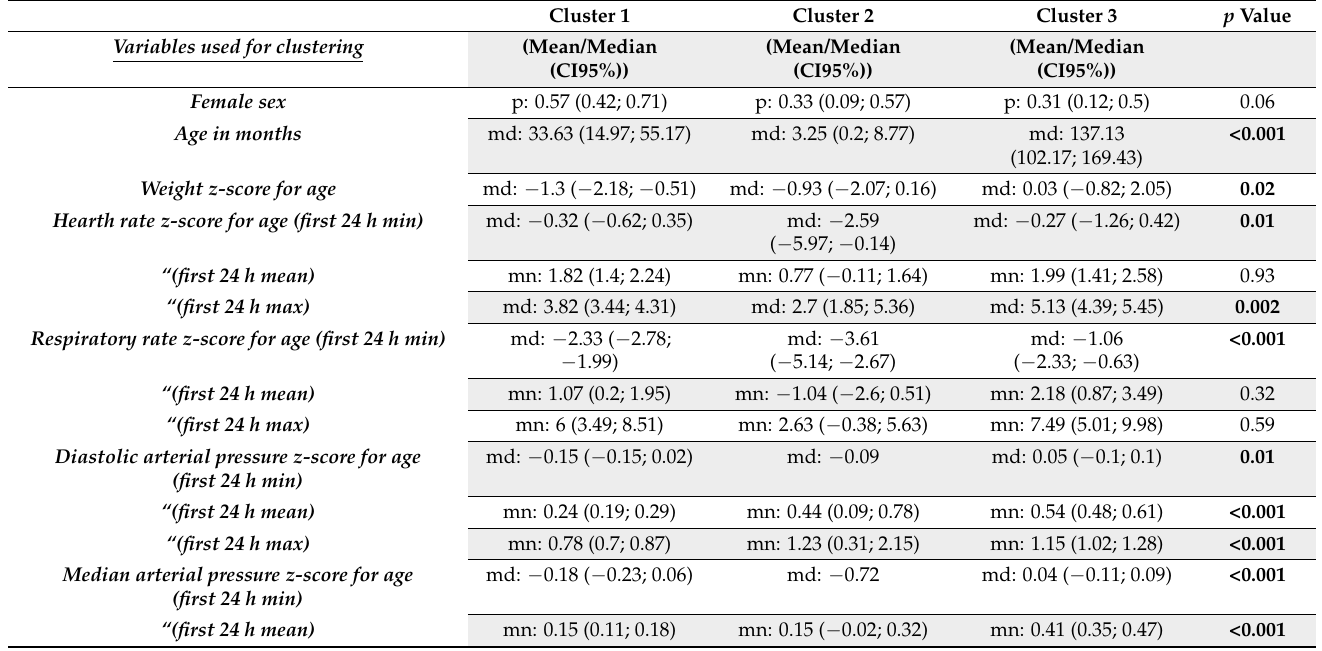
Table A1. Comparison of variables. Mean (mn) or median (md) of the 24 h first data (min, mean, max) per group according to the normality of quantitative data or proportion (p) of qualitative data, p -value of